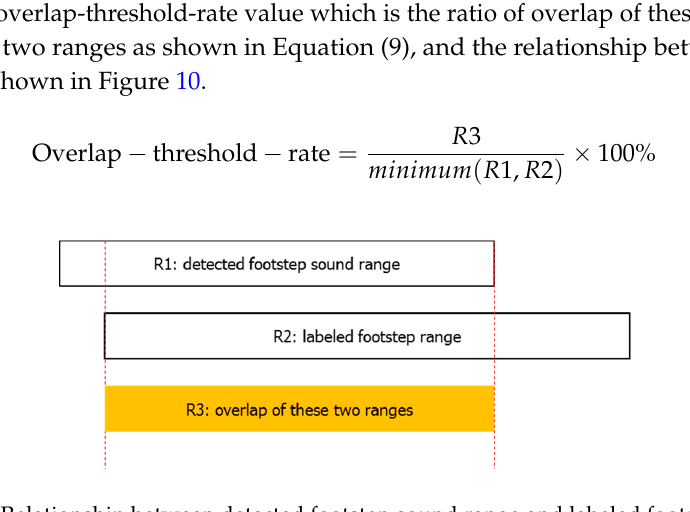
Table 4. Footstep detection results.